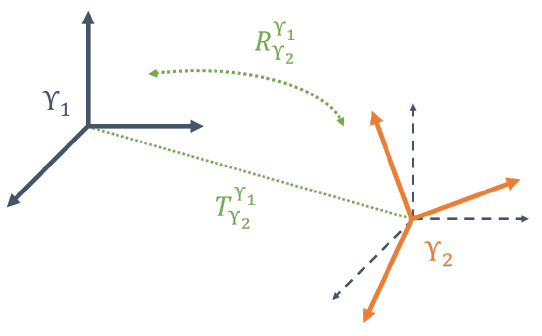
Figure 3. Rigid body transformation parameters between two arbitrary reference frames